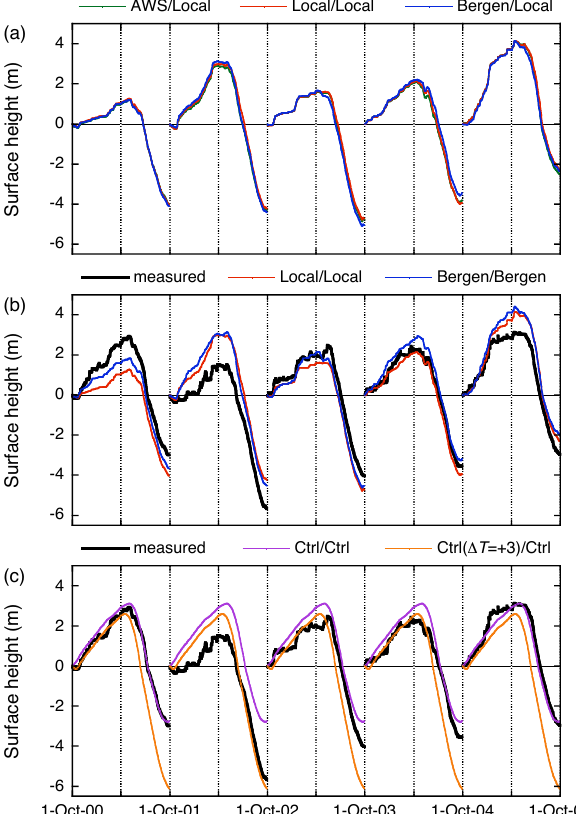
Fig. 5. Modelled surface height at AWS1 using various meteoro- logical input data sets. The legend indicates the data set used; a deviating name after the slash (/) implies that a different precipita- tion record is used, as explained in the text. (a) All simulations with local precipitation, (b) precipitation record from the corresponding data set, and (c) the control climate (Ctrl) and the control climate with a 3 ◦ C higher temperature. In (b) and (c) the measured surface height is also